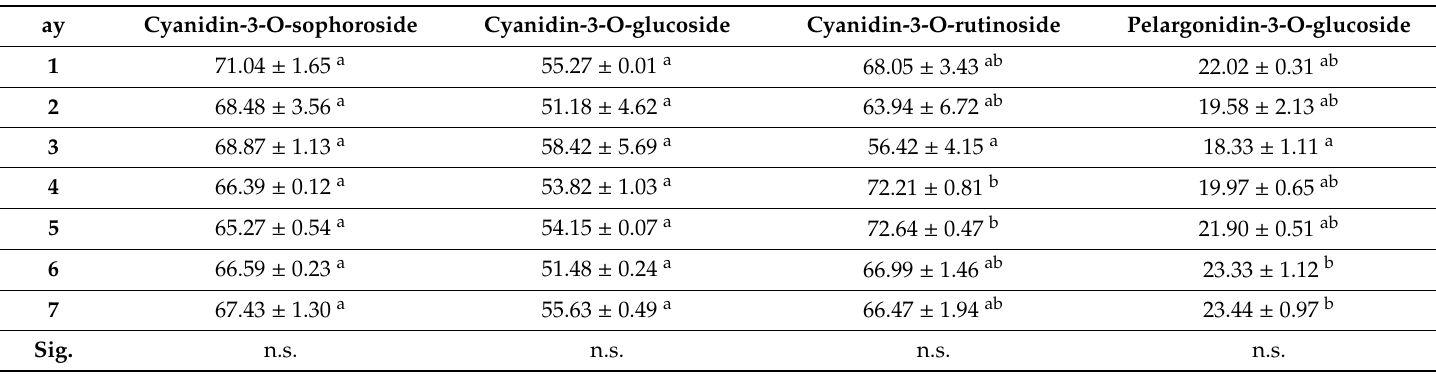
Table 19. Fruits stored at 1 ◦ C in fridge, packaged in Nanoactive B film. E ff ect of storage period on the di ff erent anthocyanidin compounds content in red raspberries (cv. Erika). Results are expressed in µ g / g of fresh weight. The results are the mean of three replicates ± Standard Deviation. n.s. (not significant). The letters represent the significant di ff erence vertically at P ≤